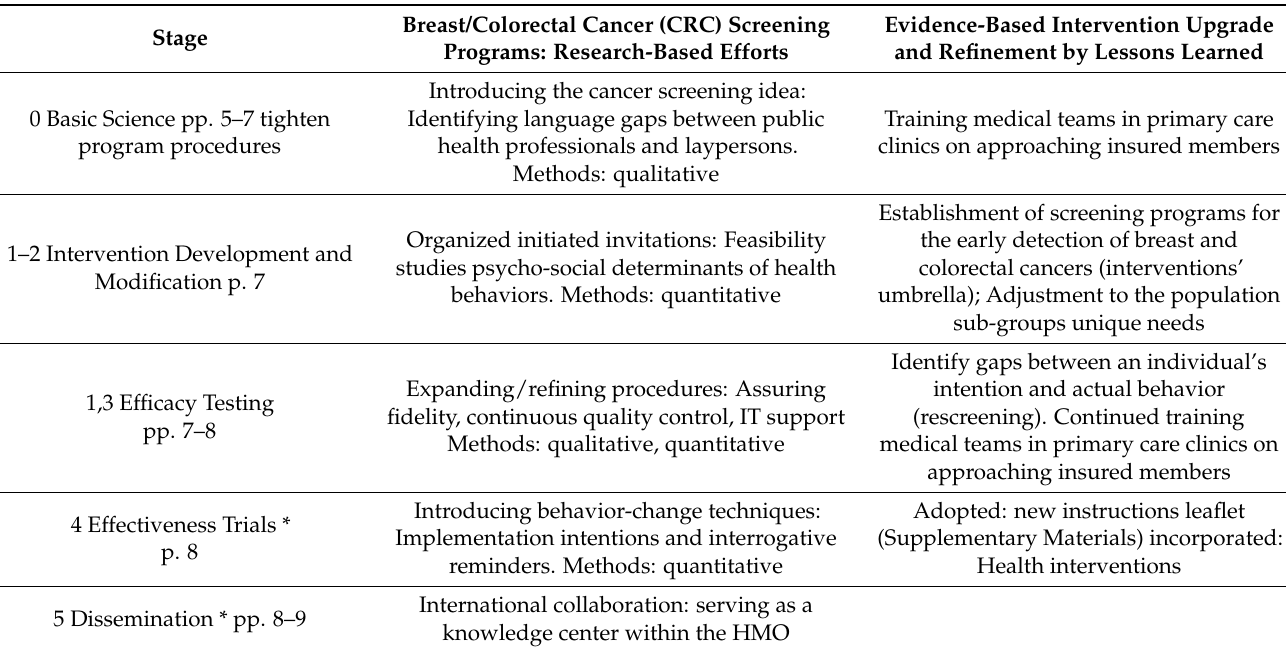
Table 1. The translational process: research—intervention cycle along NIH Stage Model. Stage Programs: Research-Based Efforts